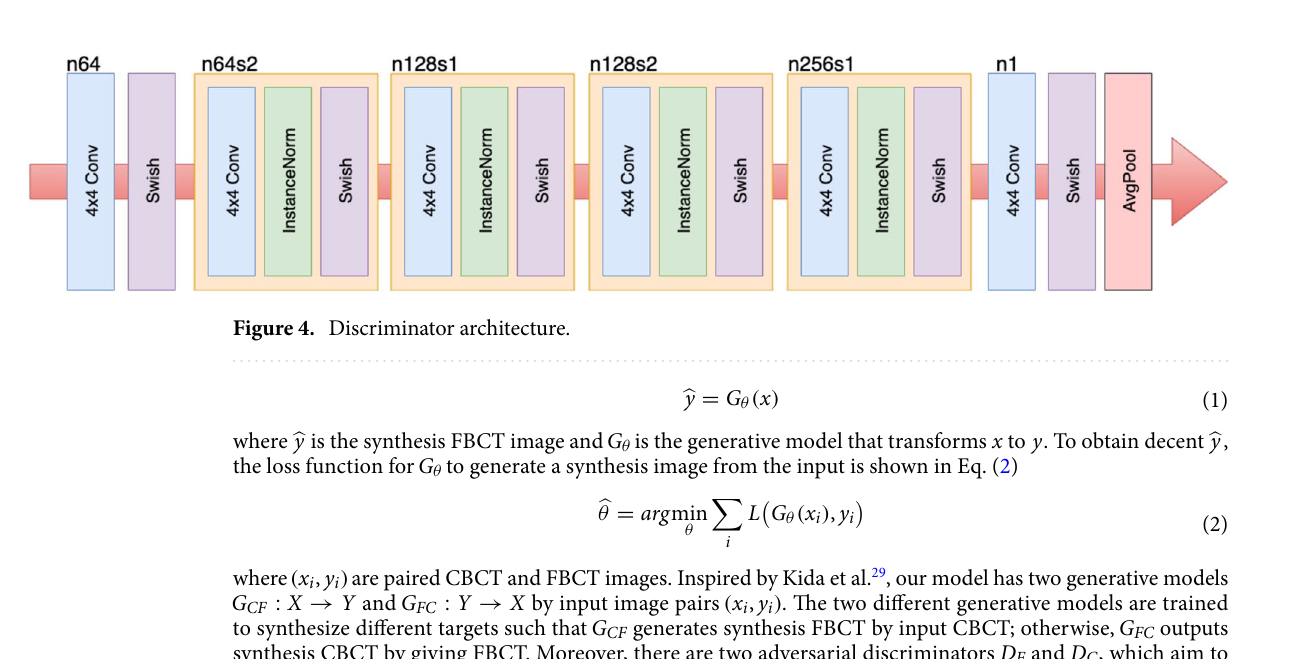
Figure 3. InceptionBlock architecture. It uses different kernel sizes of convolutional layers and deals with detailed and brief features.